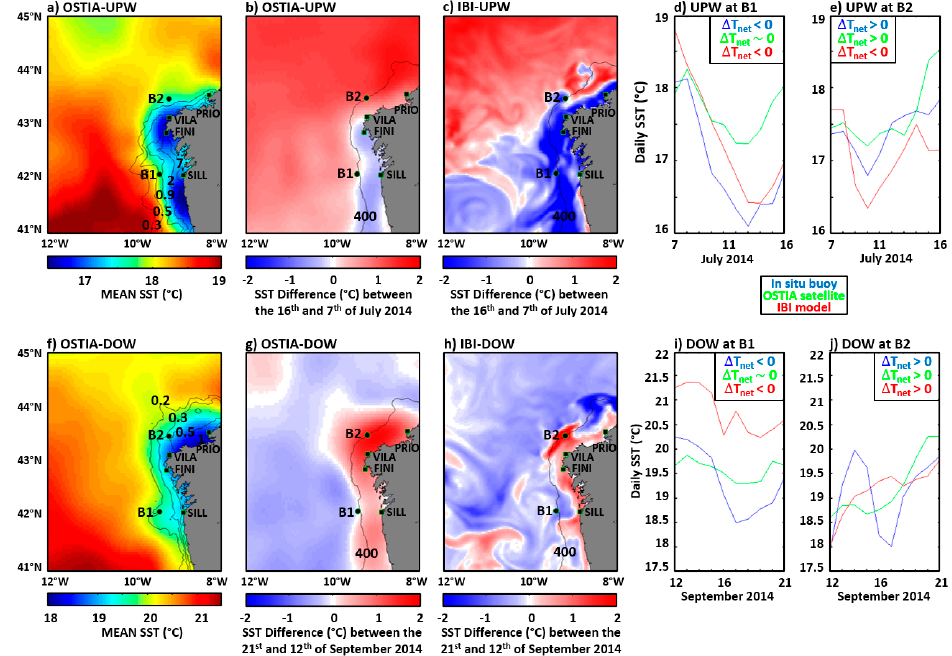
Figure 8. ( a ) Ten-day averaged map of OSTIA-derived sea surface temperature (SST, colors) and chlorophyll concentration (CHL, isolines) for the upwelling (UPW) event comprised between the 7th and 16th July 2014. ( b , c ) SST differences between the end and the beginning of the UPW event, computed from OSTIA satellite and IBI model daily estimations, respectively. ( d , e ) Daily evolution of SST at B1 and B2 buoys location, respectively, as derived from in situ observations (blue line), OSTIA estimations (green line) and IBI model outputs (red line). ( f ) Ten-day averaged map of OSTIA-derived SST and CHL for the downwelling (DOW) event comprised between the 12th and 21st September 2014. ( g , h ) SST differences between the end and the beginning of the DOW event, computed from OSTIA satellite and IBI model daily estimations, respectively. ( i , j ) Daily evolution of SST at B1 and B2 buoys location, respectively, as derived from in situ observations (blue line), OSTIA estimations (green line) and IBI model outputs (red line).